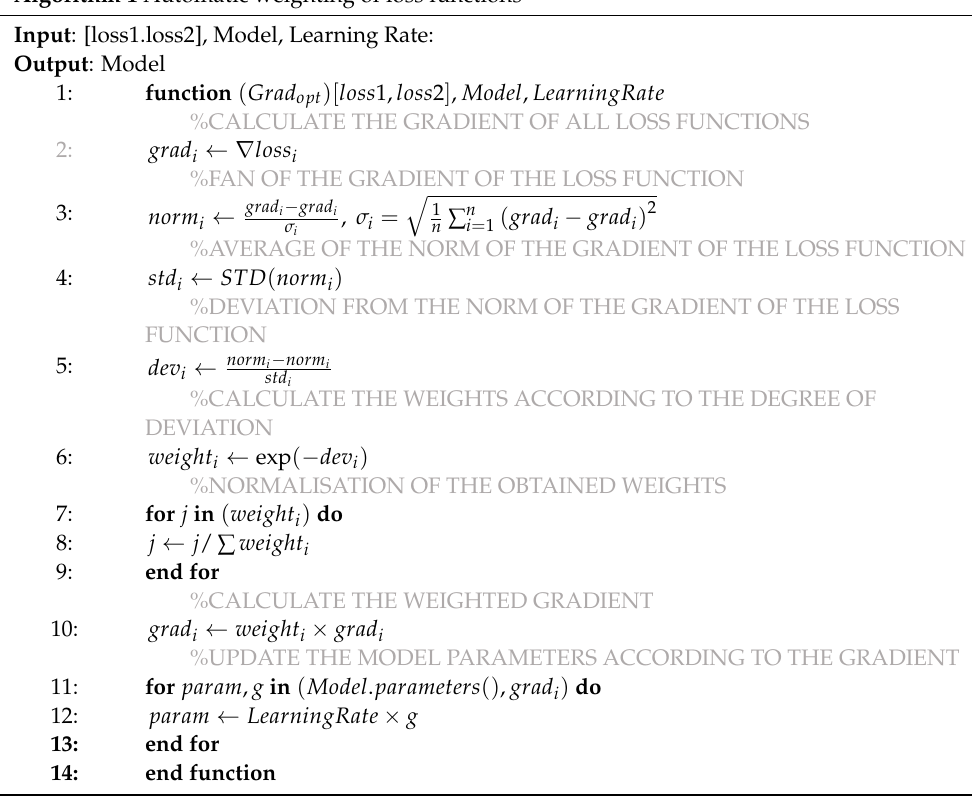
Algorithm 1 Automatic weighting of loss